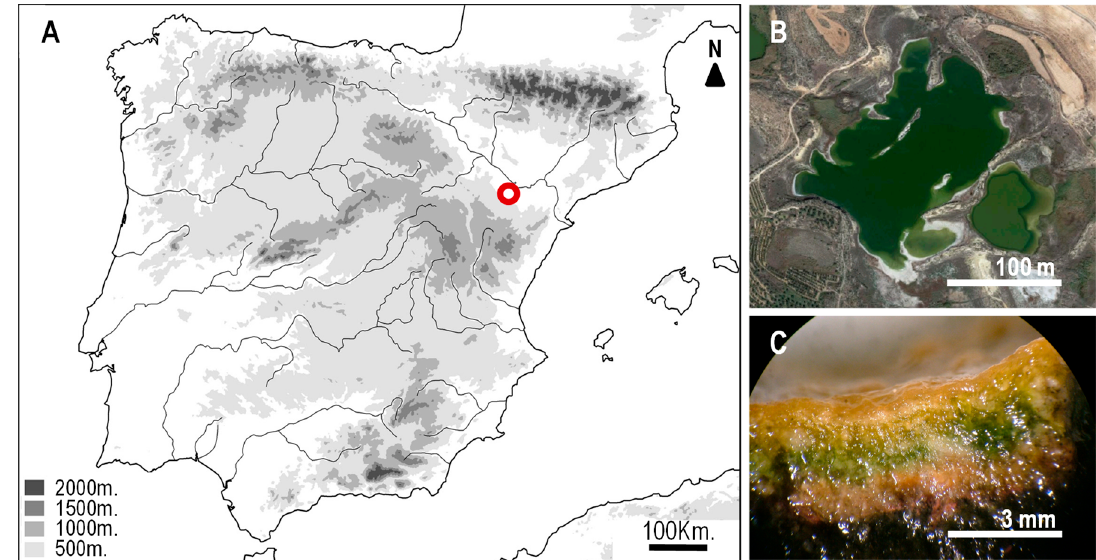
Figure 1. ( A ) Map showing the location of the Lake Salada de Chiprana (Zaragoza, Spain) (red spot) in the semi-arid region of the Ebro depression (Aragon, NE Spain). ( B ) Satellite view of the lake (Google Earth). ( C ) Section of the microbial mat from the Salada de Chiprana showing the multilayered organization. Although it is impossible to determine the exact composition of fossil mats, cyanobacterial photosynthetic mats (as those assumed to be present in past ecosystems) have common features [59,60] that allow the assumption that recent mats are a good analog.